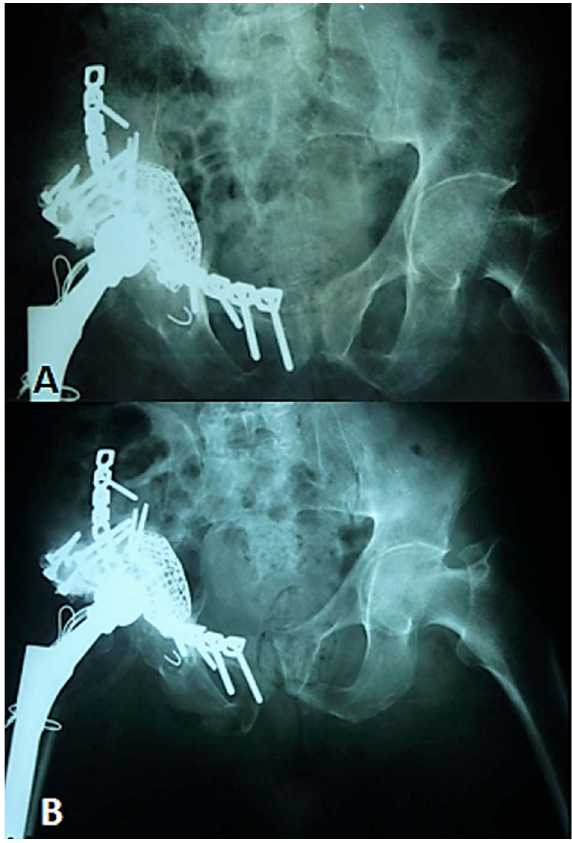
Figure 6. A-two year Postoperative follow up, B-immediate